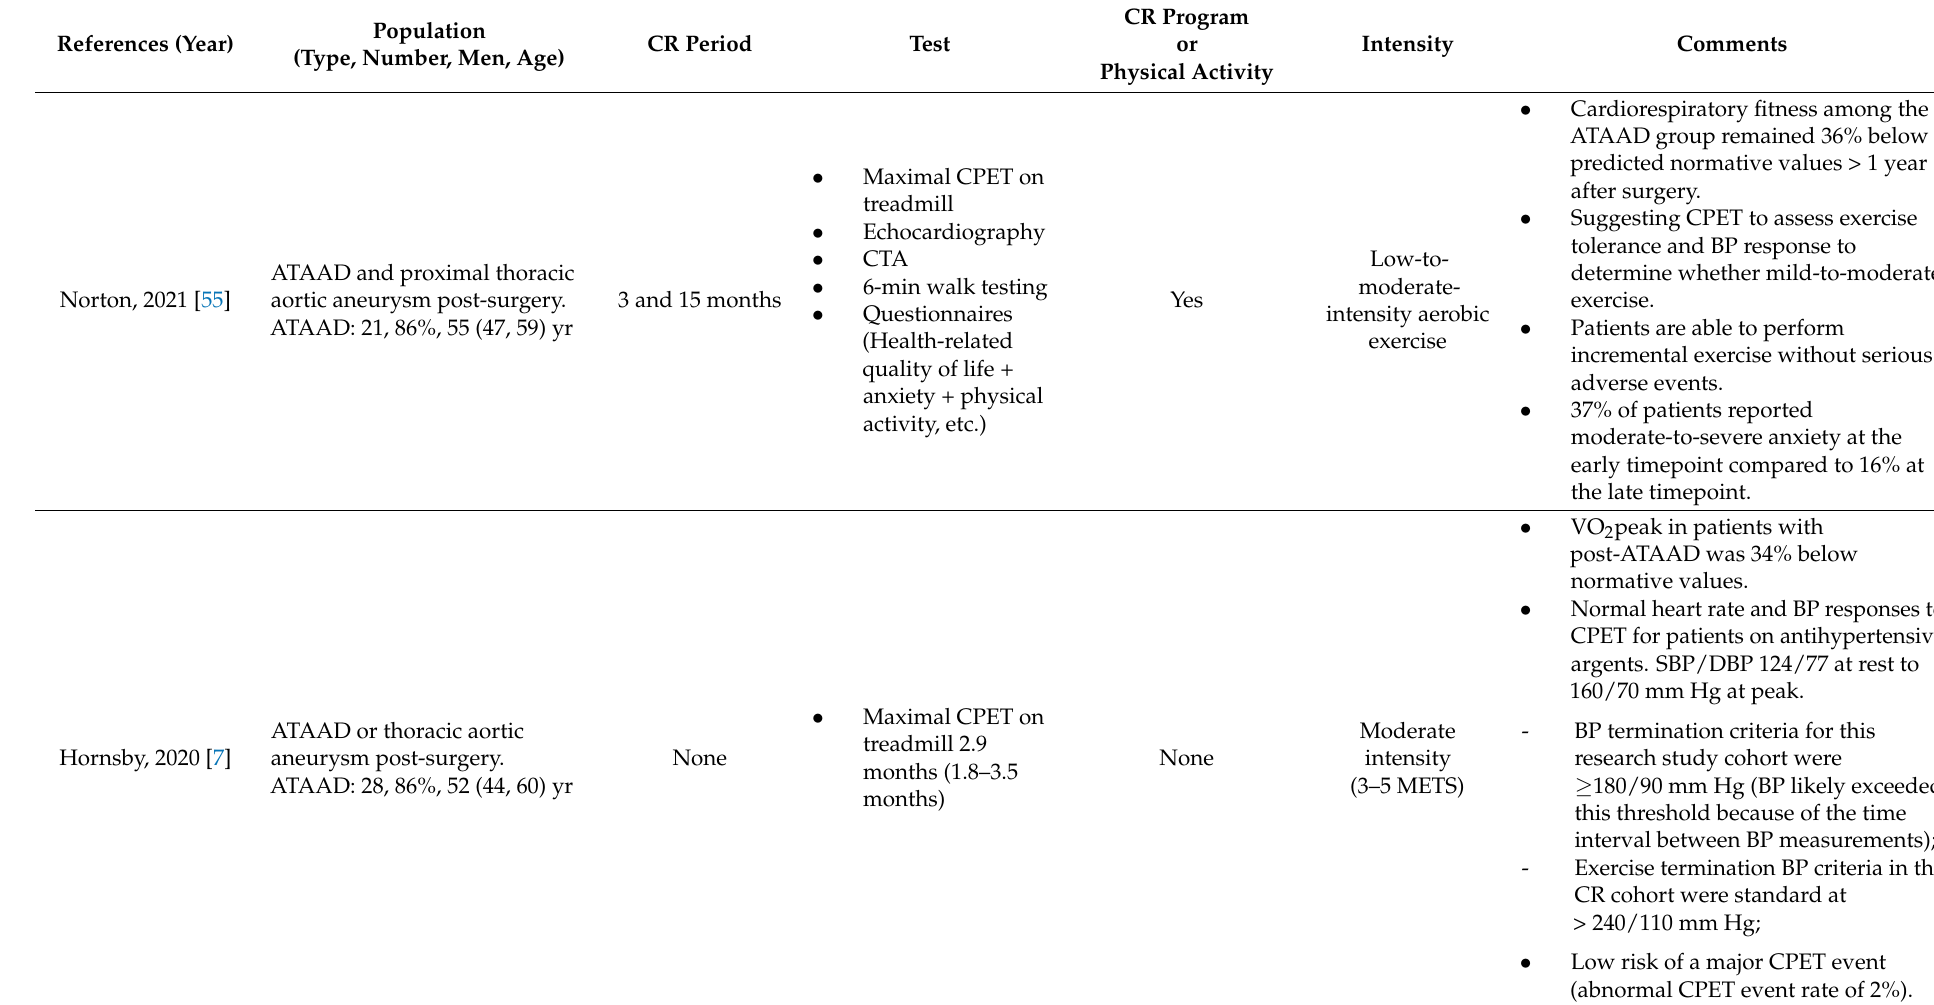
Table 1. Studies related to exercise testing or training after ATAAD